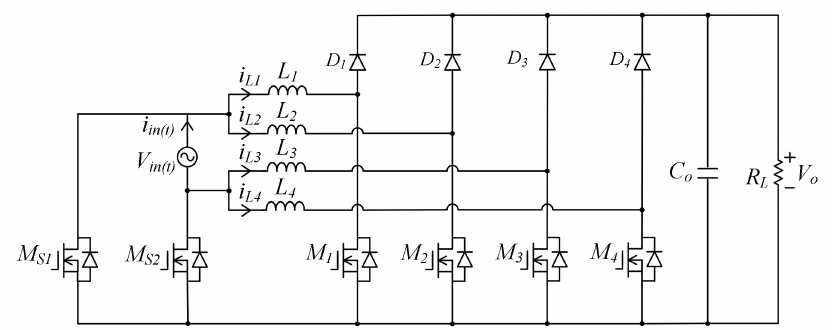
Figure 5. Schematic diagram of the modified interleaving bridgeless boost converter with a low CM noise for PFC